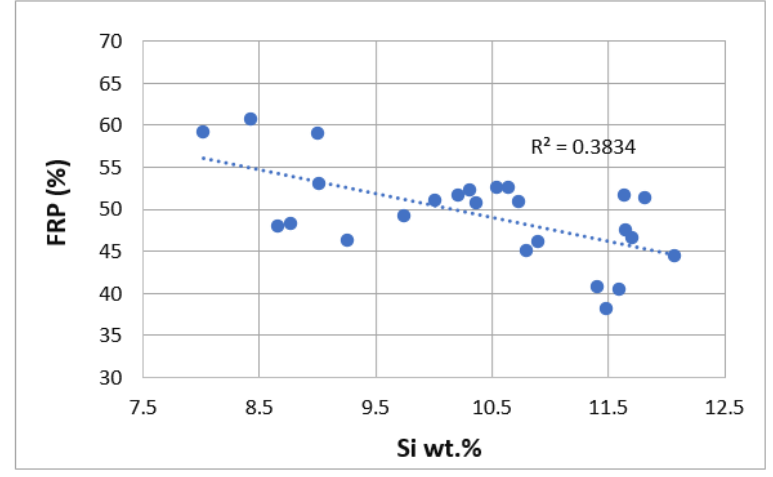
Figure 3. Comparison of FRP (%) as a function of Si (wt.%).